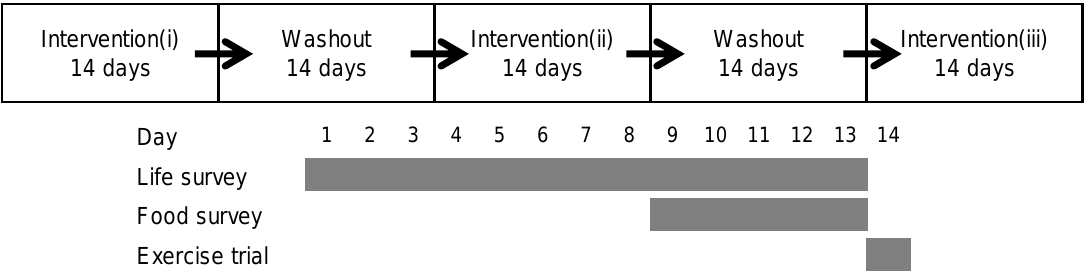
Figure 1. The protocol of the present study. This study was carried out in crossover manner. The subjects were examined on 3 interventions separated by a washout period of 14 days. In the intervention, the participants were asked to ingest test drink (containing 0 g of medium-chain triglycerides (MCTs) as control or 6 g of octanoic-acid rich MCTs or 6 g of decanoic-acid rich MCTs) and to record their consumption each day for 13 days. They were instructed to maintain their physical activity at a fixed level and to record their activity time for 13 days. They were also asked to record all meals consumed from days 9 to 13 and to abstain from exercise and alcohol on day 13. On day 14, exercise trial was conducted in each intervention. Intervention (i); the first period of intervention; intervention (ii): the second period of intervention; intervention (iii): the third period of intervention.